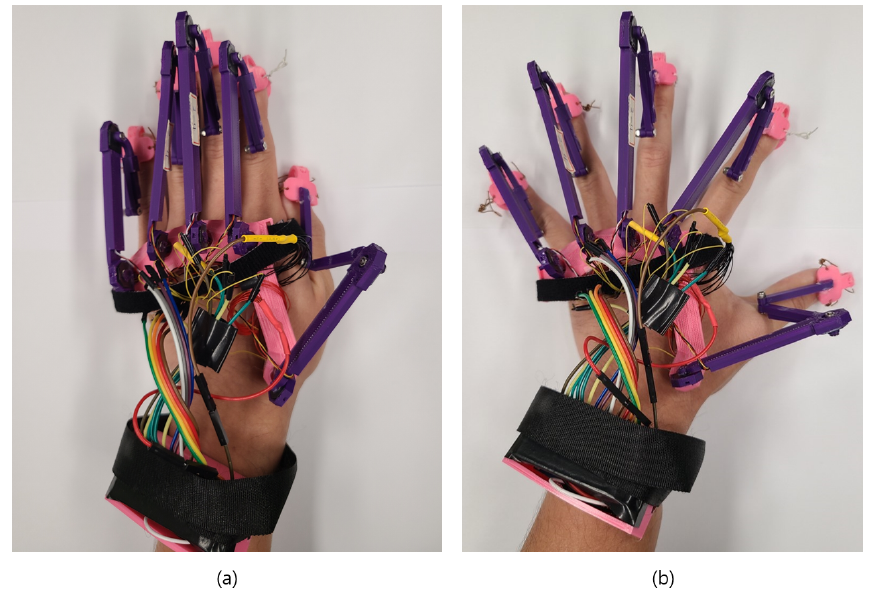
Figure 5. Adduction and Abduction movements with proposed haptic glove. ( a ) demonstration of adduction movements of 0 ◦ which is considered to be the base adduction value in the proposed haptic glove. ( b ) demonstration of abduction movements of 40 ◦ which is considered to be the maximum abduction value in the proposed haptic